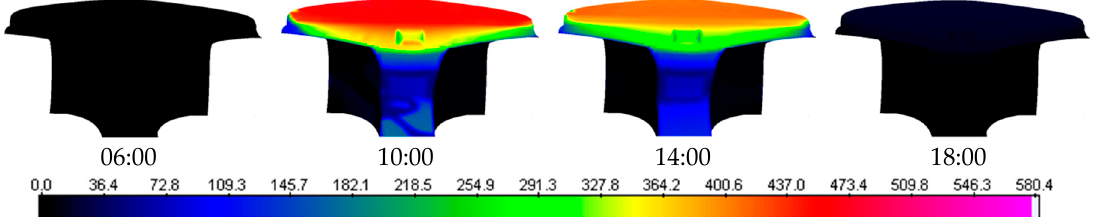
Figure 8. Distribution and variation of solar radiation intensity on instrument table system at multiple moments (W/m 2 ).